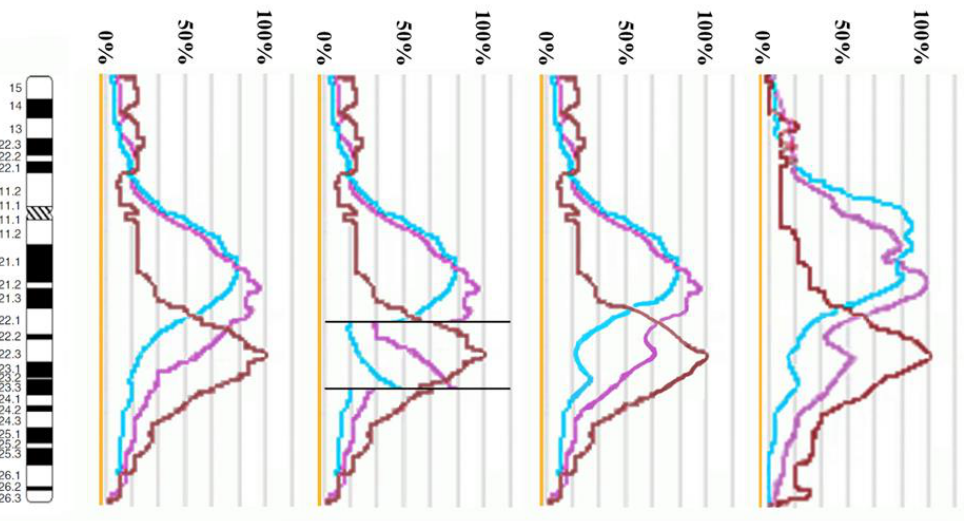
Figure 5. The scheme of hypothetical breakpoints of inverted regions in 10q22.1 → q23.3 bands, as proposed on the basis of GTG-banding analysis.